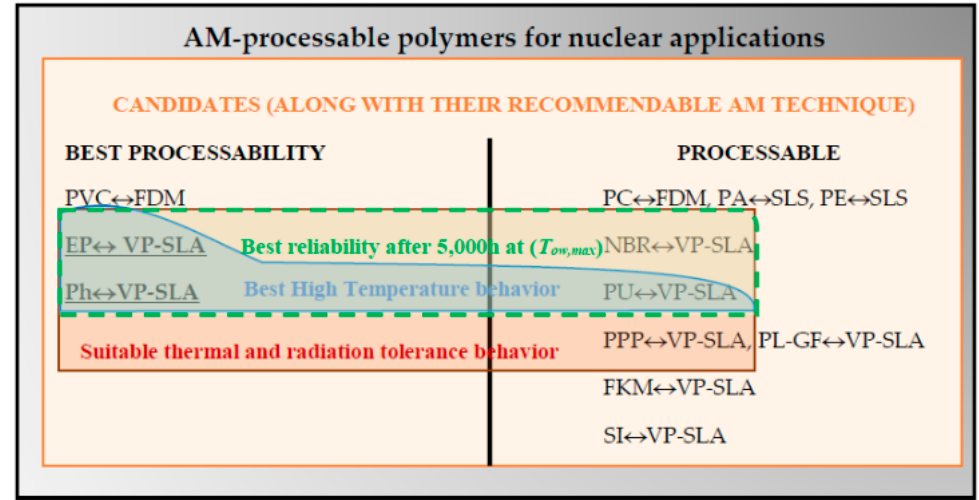
Figure 11. Material selection chart for nuclear applications.